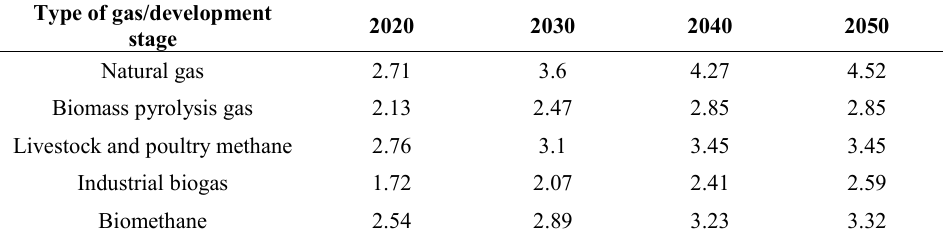
Table 3. Biomass Gas Cost Analysis (Unit: Yuan/m 3